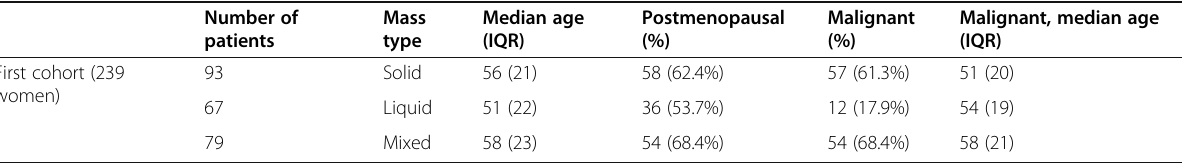
Table 1 First cohort